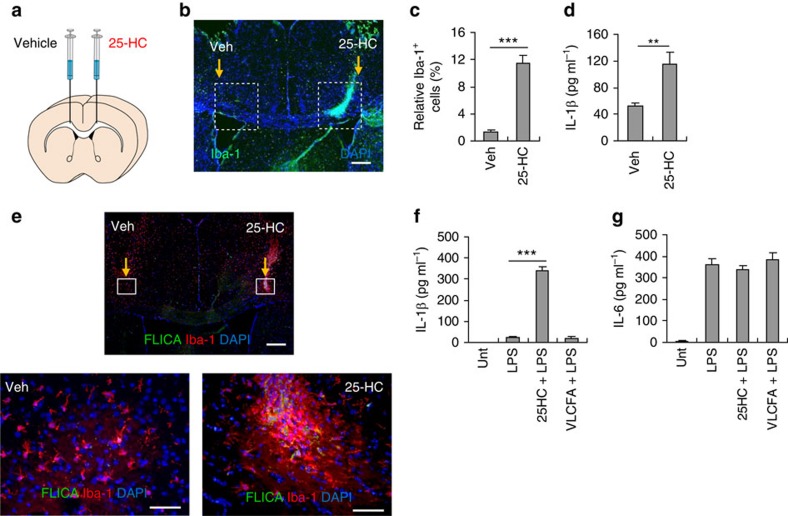
25-HC induces microglial recruitment and IL-1β production.(a) Illustration of stereotaxic injection of 25-HC (100 μM) or vehicle (0.1% ethanol in PBS) into the corpus callosum of mouse brain. (b) Representative immunofluorescence image of a coronal brain section stained with anti-Iba-1 antibody (green). DAPI represents the nuclear signal (blue). Scale bar, 200 μm. (c) Quantification of Iba-1-positive cells in the boxed areas of vehicle- or 25-HC-injected regions in b. (n=8) (d) Quantification of IL-1β in the brain homogenates of vehicle- or 25-HC-injected hemisphere. (n=11) (e) Representative immunofluorescence image of brain section co-stained with FLICA (green) and anti-Iba-1 antibody (red) after injection of vehicle or 25-HC. Magnified immunofluorescence images of the boxed areas in the upper panel are displayed in the lower panel: 25-HC-injected area (right) or vehicle-injected area (left). Scale bars, 200 μm (upper); or 50 μm (lower). (f,g) Quantification of IL-1β or IL-6 in the culture supernatants of mouse BMDMs untreated or treated with 25-HC (70 μM) or VLCFA (70 μM) for 10 h in the presence of LPS (0.25 μg ml−1, last 4 h) as indicated. (n=6). For all panels, **P<0.01 and ***P<0.001.